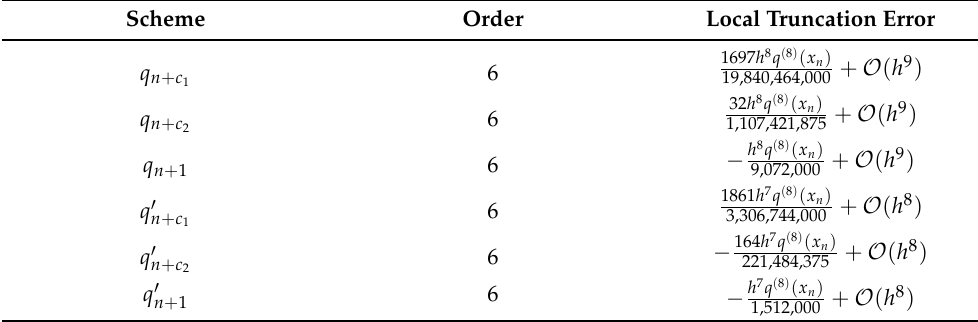
Table 1. Order (p) and local truncation errors (LTEs) for the TDHBM method. Scheme